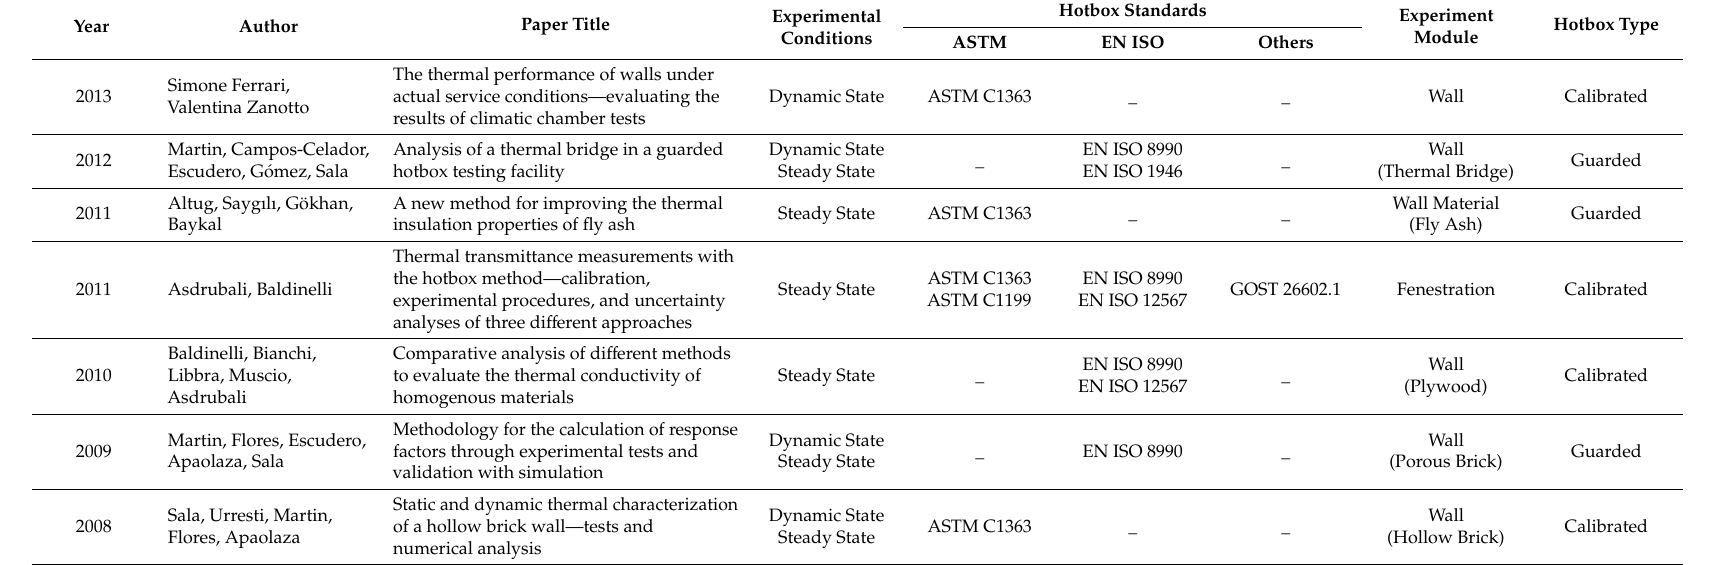
Table 1. Detailed description of the selected studies utilizing similar standards of measurements and similar